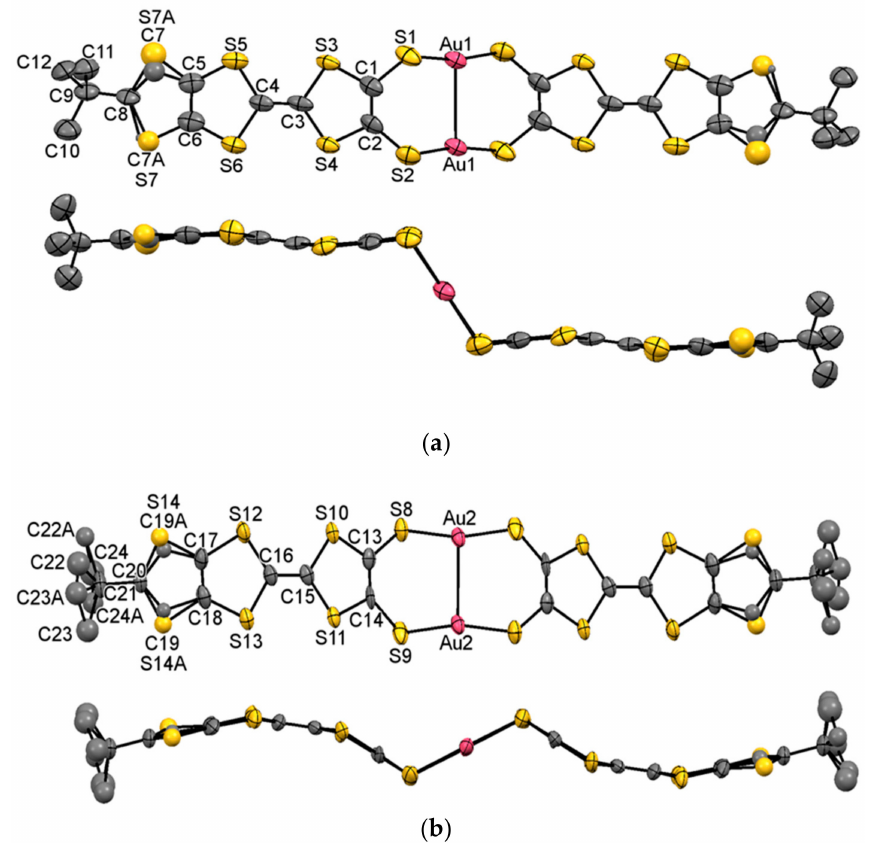
Figure 4. ORTEP and atomic numbering schemes (top and side views) of [Au( α -tbtdt) 2 ] anions Au1 ( a ) and Au2 ( b ) in the crystal structure of ( n -Bu 4 N) 2 [Au 2 ( α -tbtdt) 2 ] ( 5 ), with thermal ellipsoids drawn at 50% probability level. Hydrogen atoms were omitted for